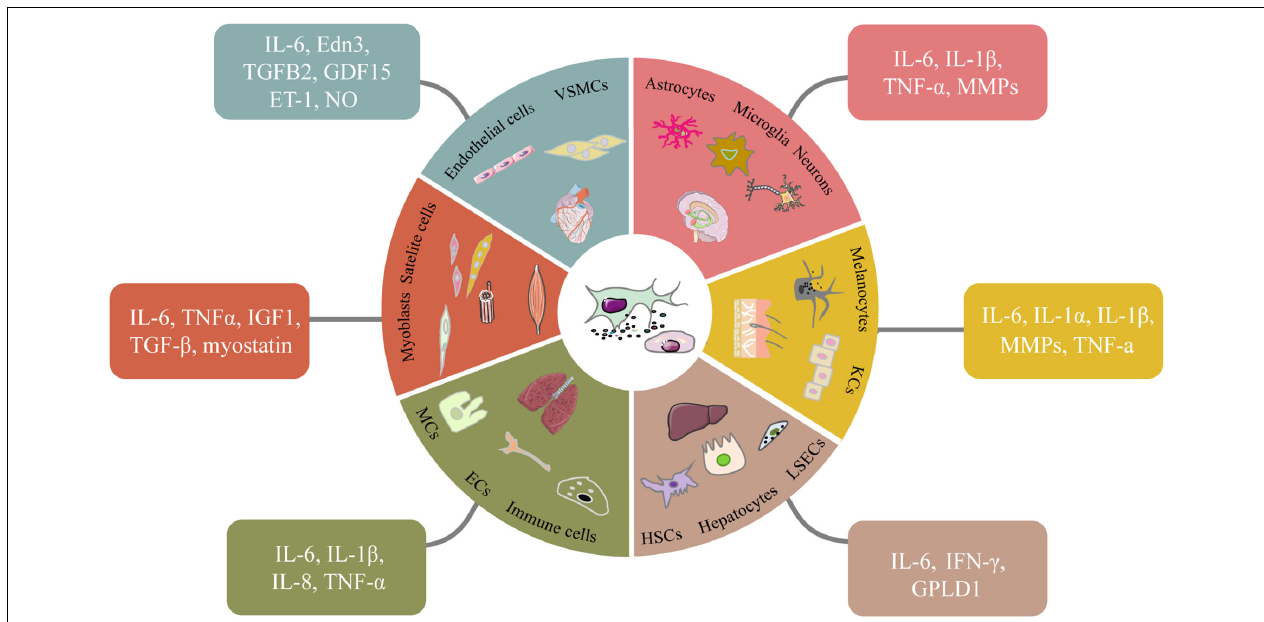
FIGURE 2 | Senescent cell types and the SASP factors they secret in different tissues. In different tissues, various senescent cells secrete classic or specific SASP factors in autocrine and paracrine ways. Some signaling molecules such as NO which accordingly change to elevate chronic inflammation, induce tissue dysfunction and accelerate aging. VSMCs, vascular smooth muscle cells. LSECs, liver sinusoidal endothelial cells; HSCs, hepatic stellate